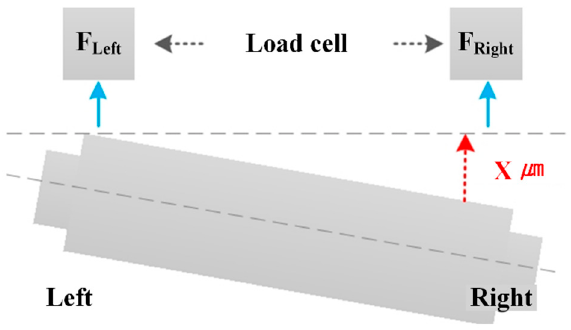
Figure 11. Schematic of automatic alignment test for roller with magnetic bearings.